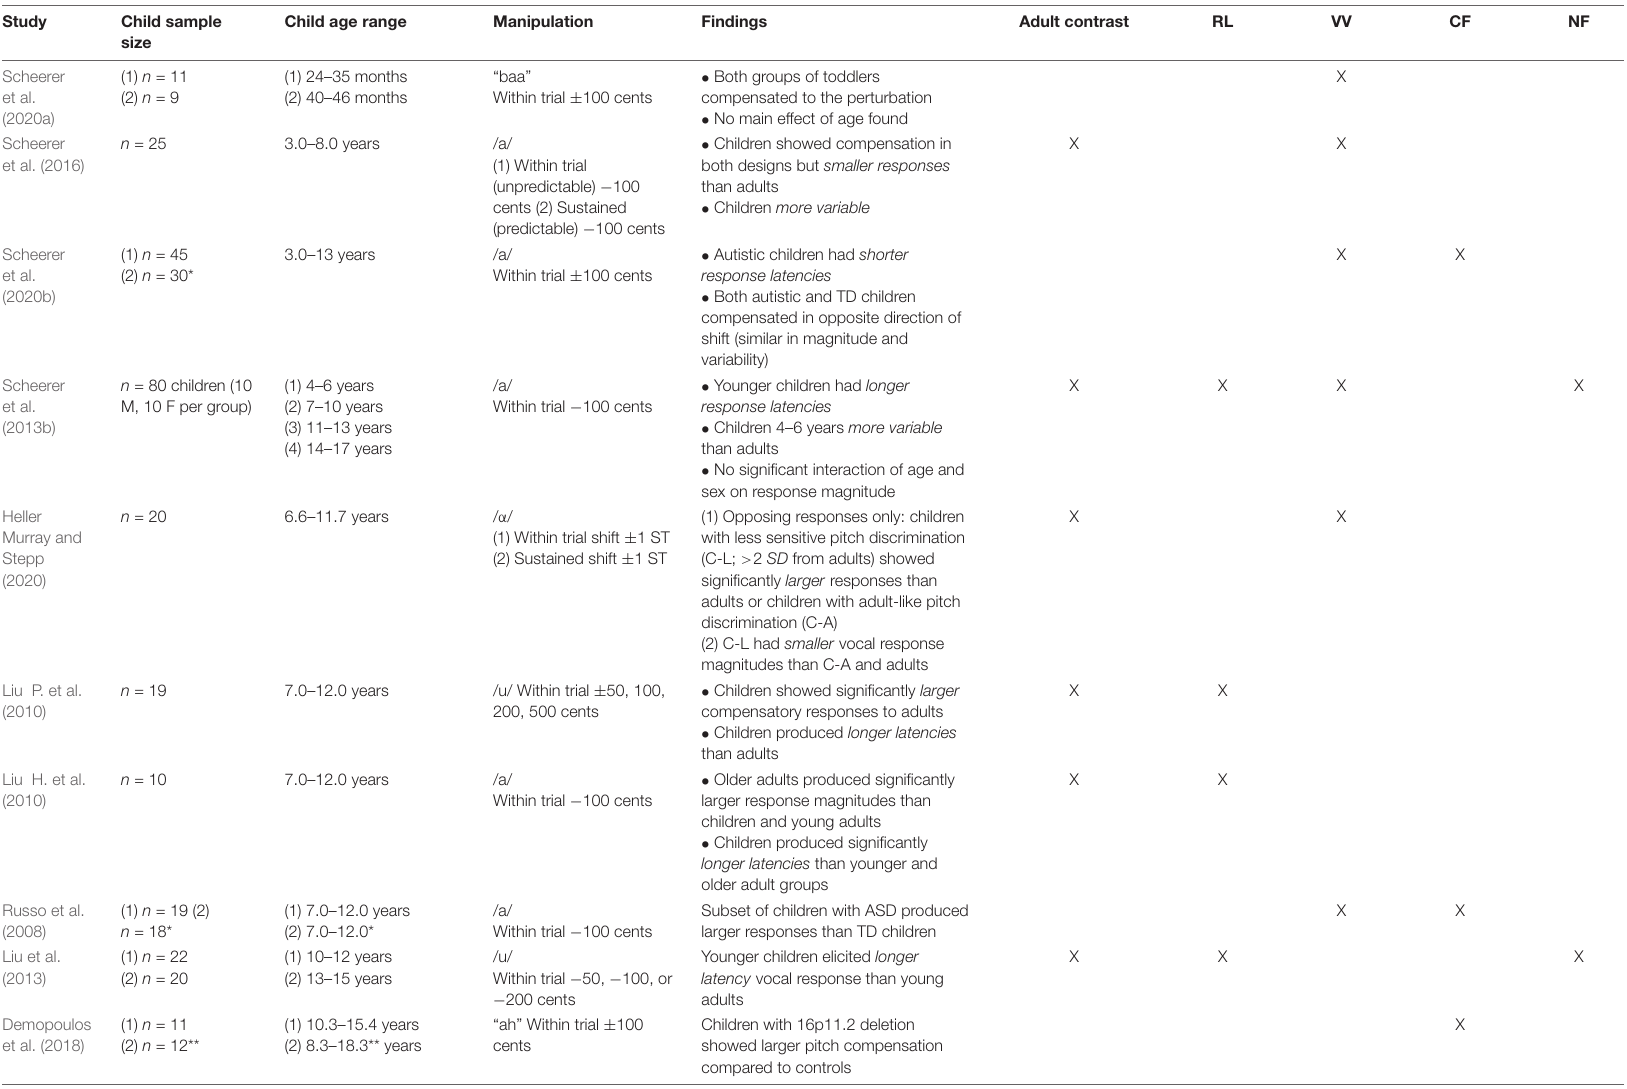
TABLE 1 | Behavioral findings in response to fundamental frequency (f 0 ) manipulated altered auditory feedback in typically developing (TD) children and children with speech and language disorders.